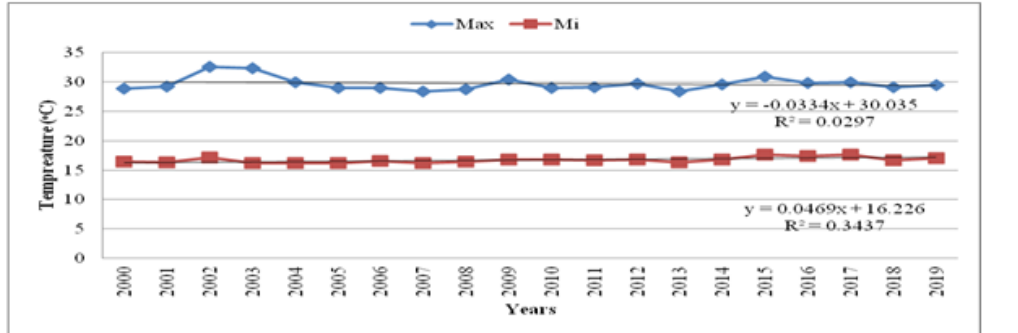
Average Annual Minimum and Maximum Temperatures in the Study Area (2000 – 2019)